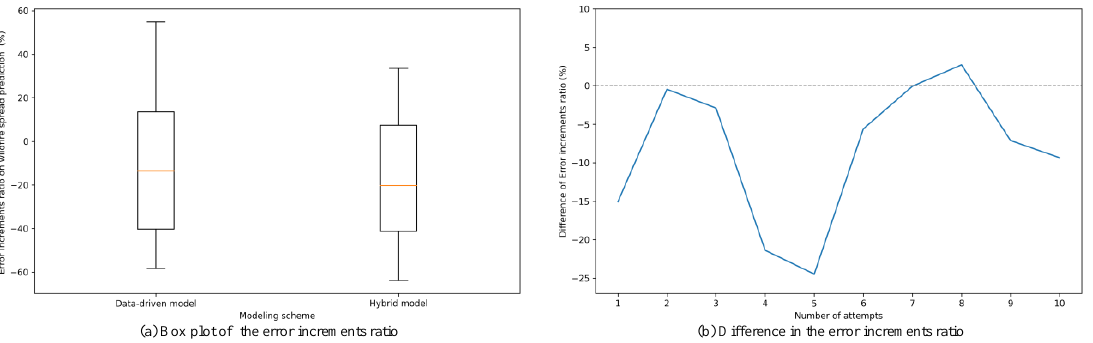
Figure 11. The simulation results on error increments ratio on wildfire spread prediction for untrained wildfire scenarios compared with wildfire spread prediction for trained wildfire scenarios.